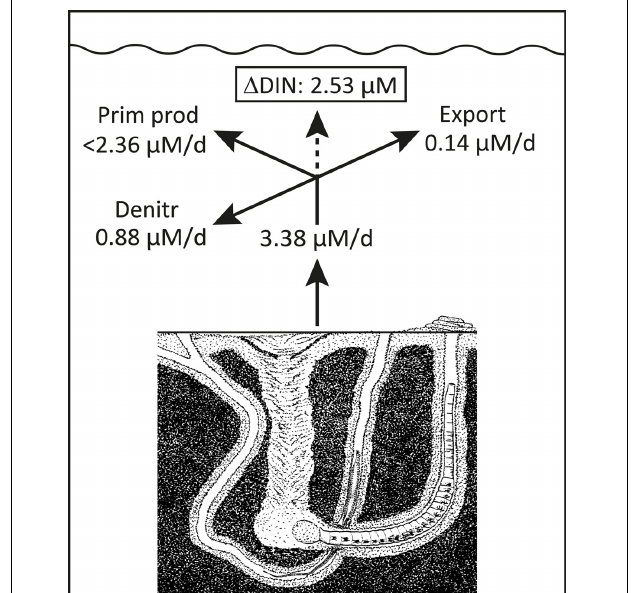
FIGURE 8 | Conceptual diagram illustrating the fate of the estimated fauna-induced 2004–2006 excess DIN release in the inner Odense Fjord. The release shown in Figure 8 are converted to concentration change based on an average water depth of 0.8m. The export is derived from an estimated average residence time of 23 days (Petersen et al., 2009). Denitrification is estimated as 26% of the DIN release (Petersen et al., 2009). The maximum phytoplankton primary production is derived from the average summer rates (Fyns Amt, 2004). These three loss terms are at most equivalent to the excess release and justify the maintenance of a high 2004–2006 DIN level in the overlying water ( Figure 2